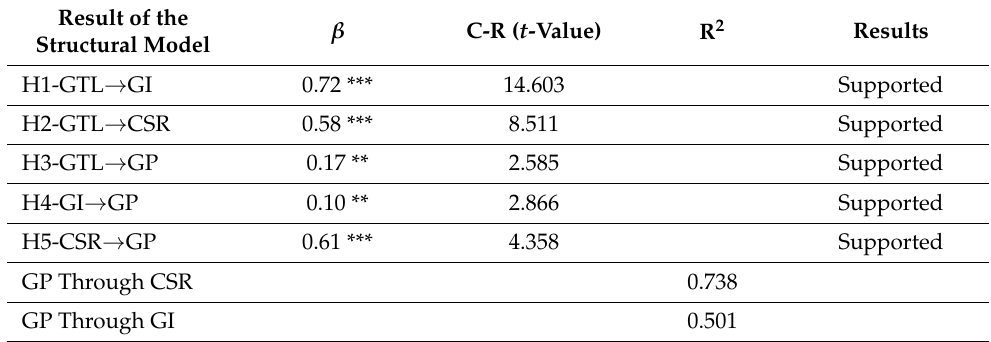
Table 3. Result of the structural model (developed by the authors using SPSS and AMOS software). Result of the Structural Model